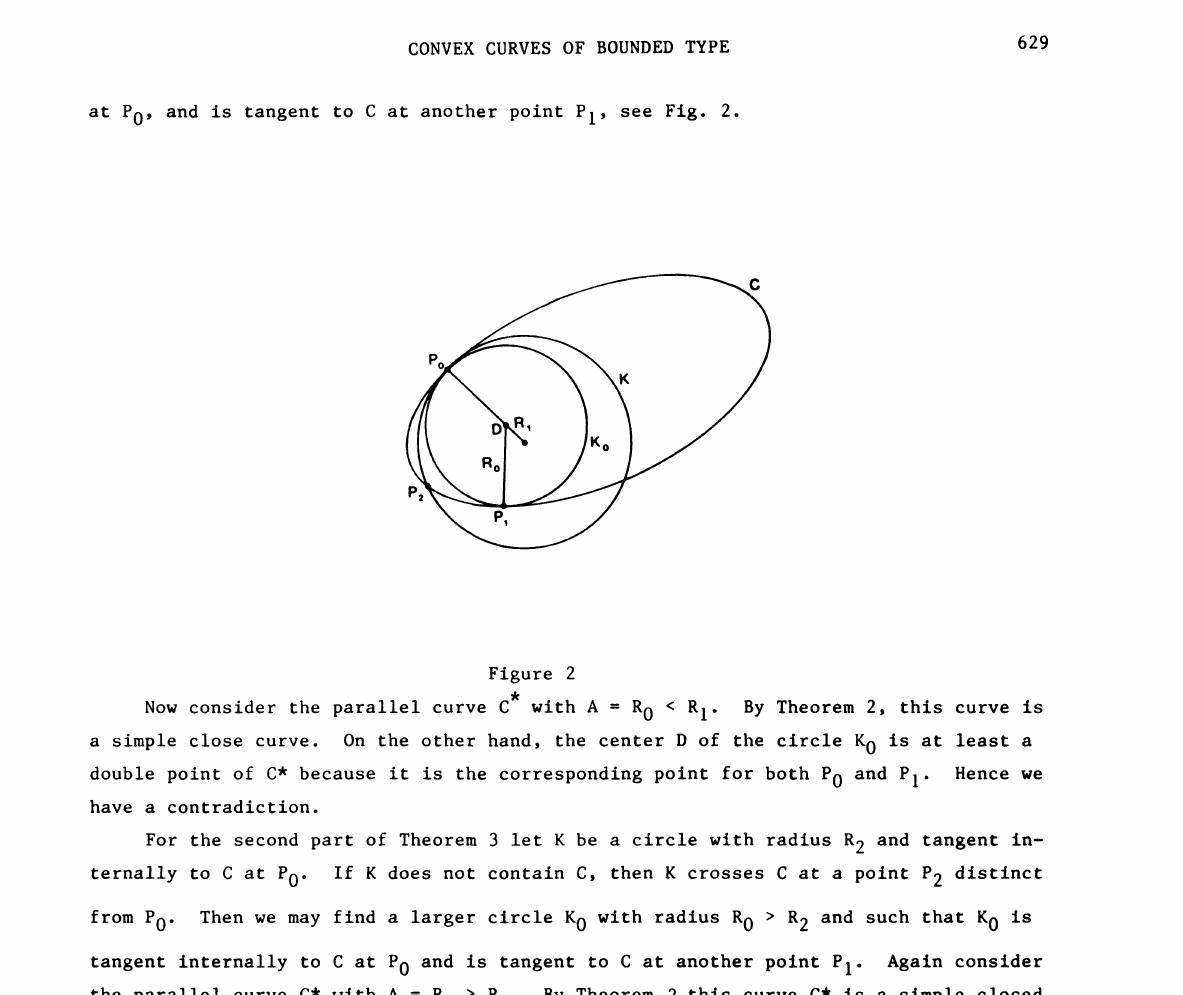
Now consider the parallel curve with A R 0 < R I. By Theorem 2, this curve